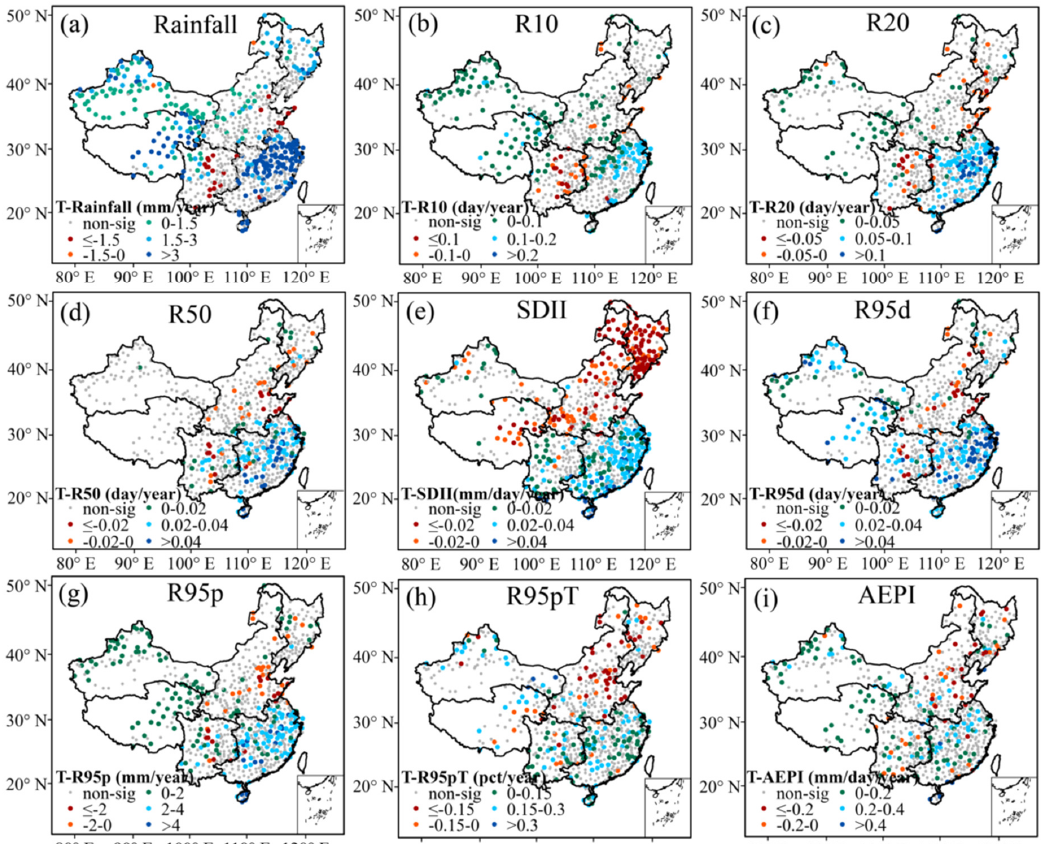
Figure 3. Trends in the EPIs in China from 1960 to 2017: ( a ) the trend in rainfall, ( b ) the trend in R10, ( c ) the trend in R20, ( d ) the trend in R50, ( e ) the trend in SDII, ( f ) the trend in R95d, ( g ) the trend in R95p, ( h ) the trend in R95pT, and ( i ) the trend in AEPI.